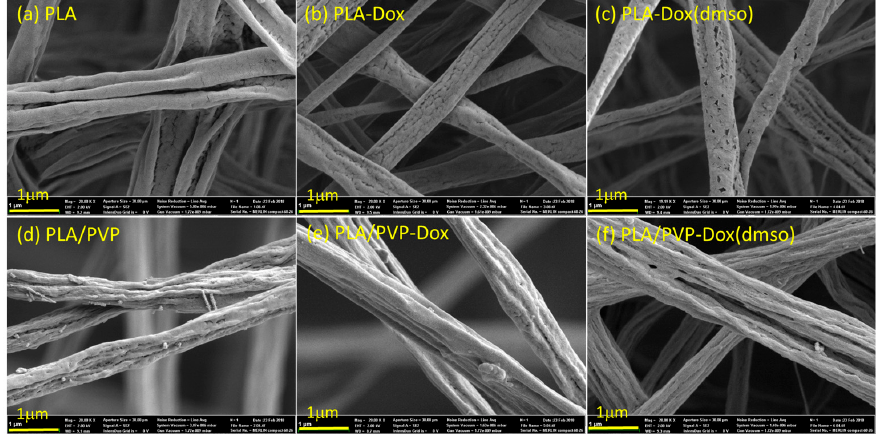
Figure 4. SEM images of doxorubicin-loaded fibers.